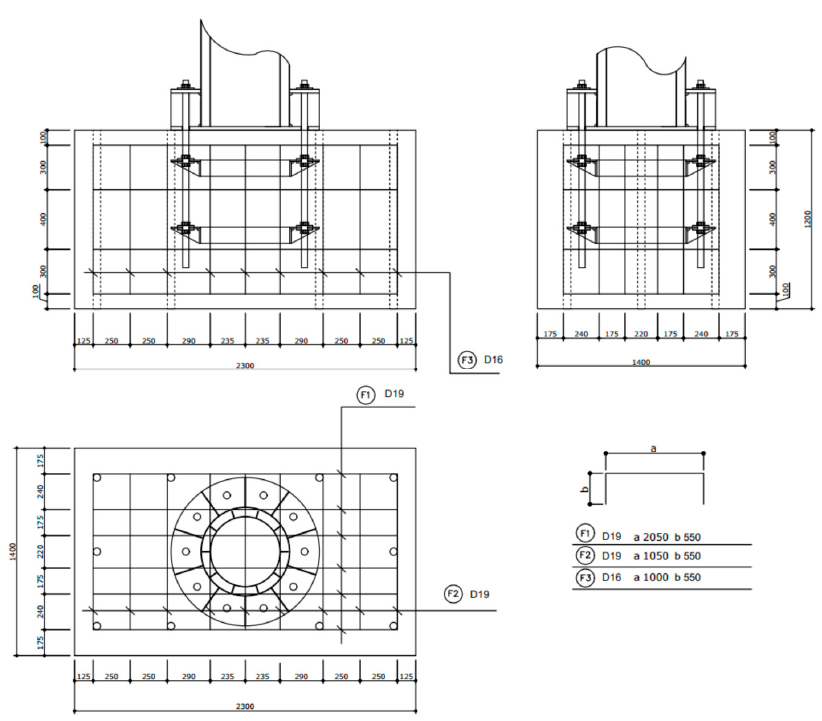
Figure 12. Anchor plate.